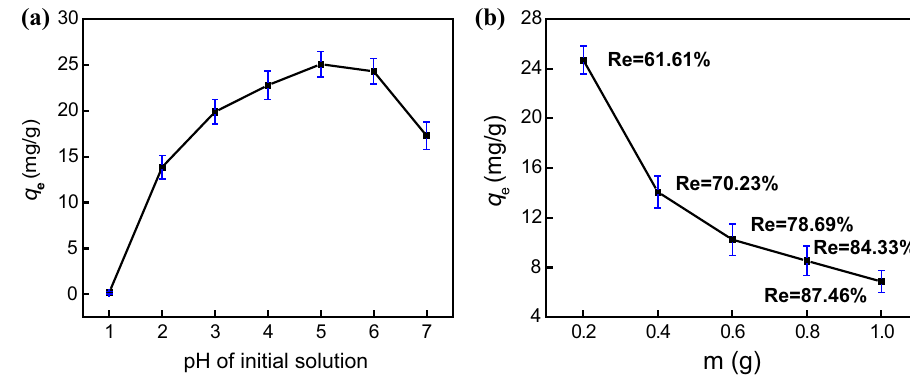
Fig. 3 Effects of pH value ( a ) and adsorbent dosage ( b ) on the adsorption of Co(II) onto the